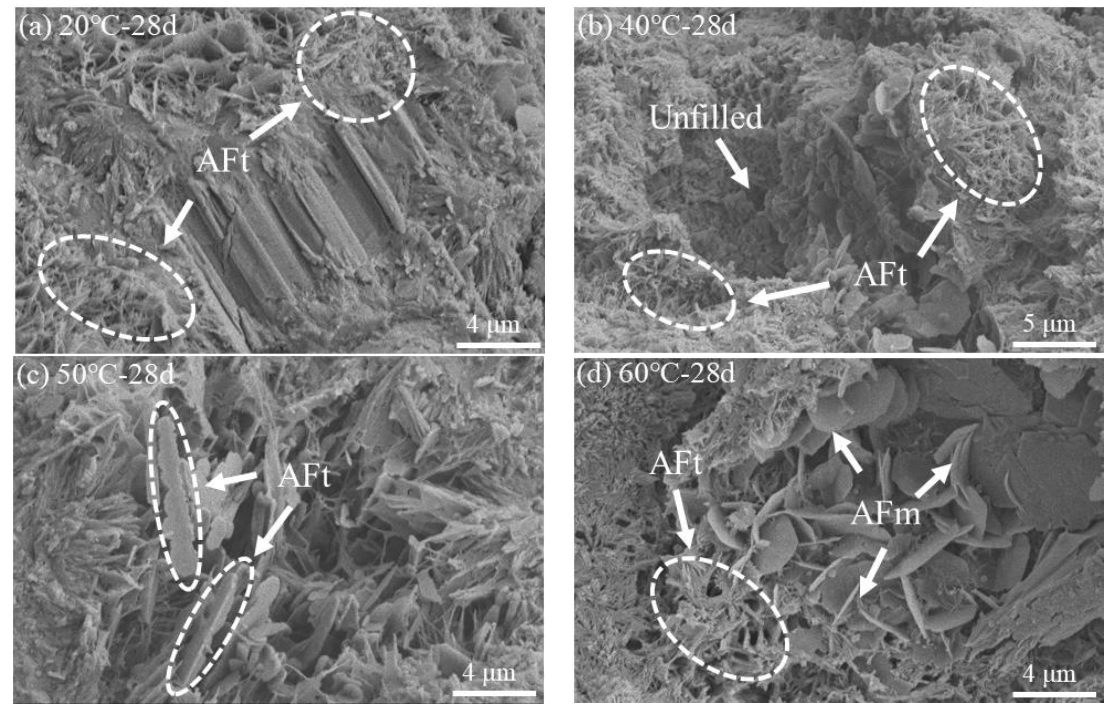
Figure 9. Microstructure of the SRPC at different curing temperatures: ( a ) 20 °C; ( b ) 40 °C; ( c ) 50 °C; ( d ) 60 °C.